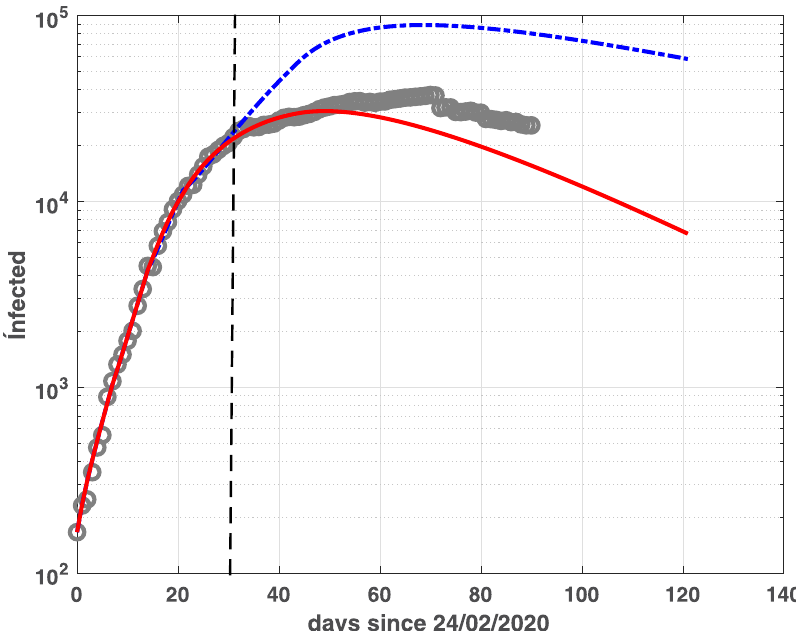
Fig 12. Prevision for infected in Lombardia. Infected population of fSEIRDe (continuous red line) and fSEIDRr (blue dash-dotted line) calibrated on the first 30 days observed infection data [24/02-27/03], delimited by the vertical black dashed line. Prediction is shown until 30 days after the last measured data (day 24/05). Grey circles represent the infected data in the period [24/02-24/05].